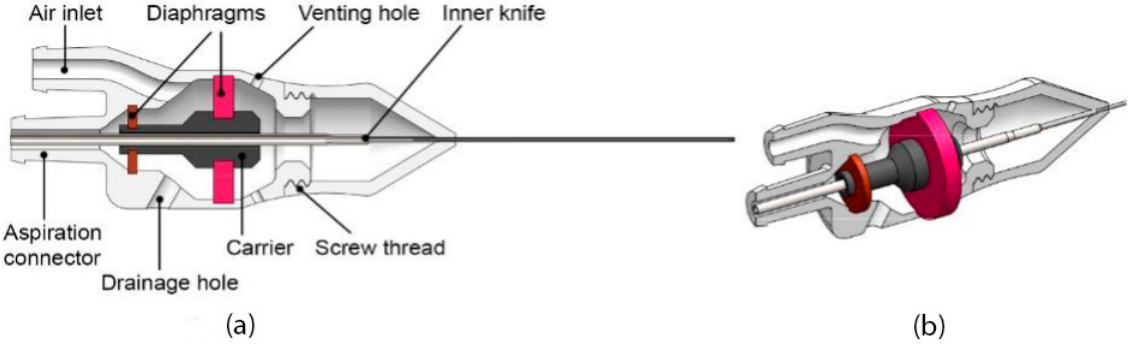
Figure 5. Design of the non-assembly vitrectome. ( a ) Cross-section showing the various components of the design. ( b ) Cross-section showing the full dual diaphragm mechanism. Diameter outer knife 0.4 mm, length outer knife 28 mm, length entire 3D printed vitrectome 80 mm.